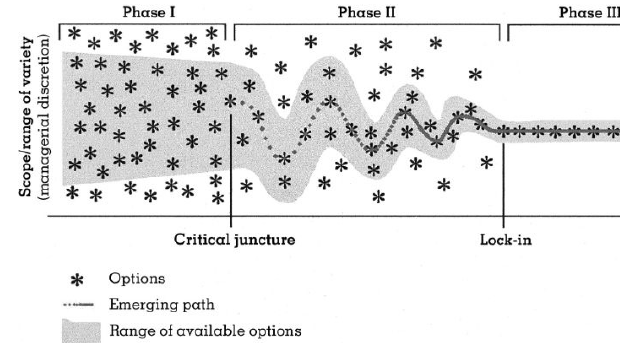
Figure 1. Path dependency leads to a lock-in situation at the end. This is currently the situation for land subsidence in many coastal areas, where an adaptation strategy is preferred over a mitigation strategy (The constitution of an organisational path figure from Sydow et al.,